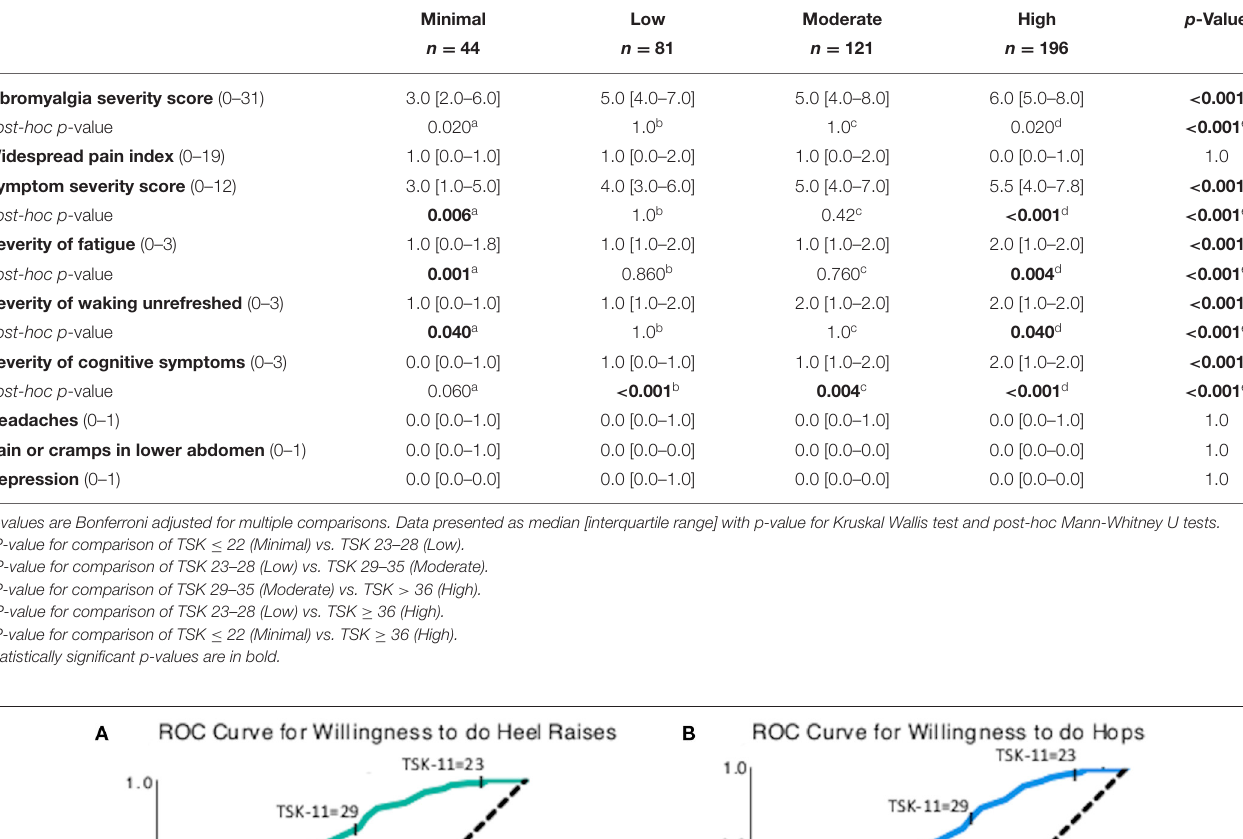
identify people for further evaluation of fibromyalgia symptoms (22,